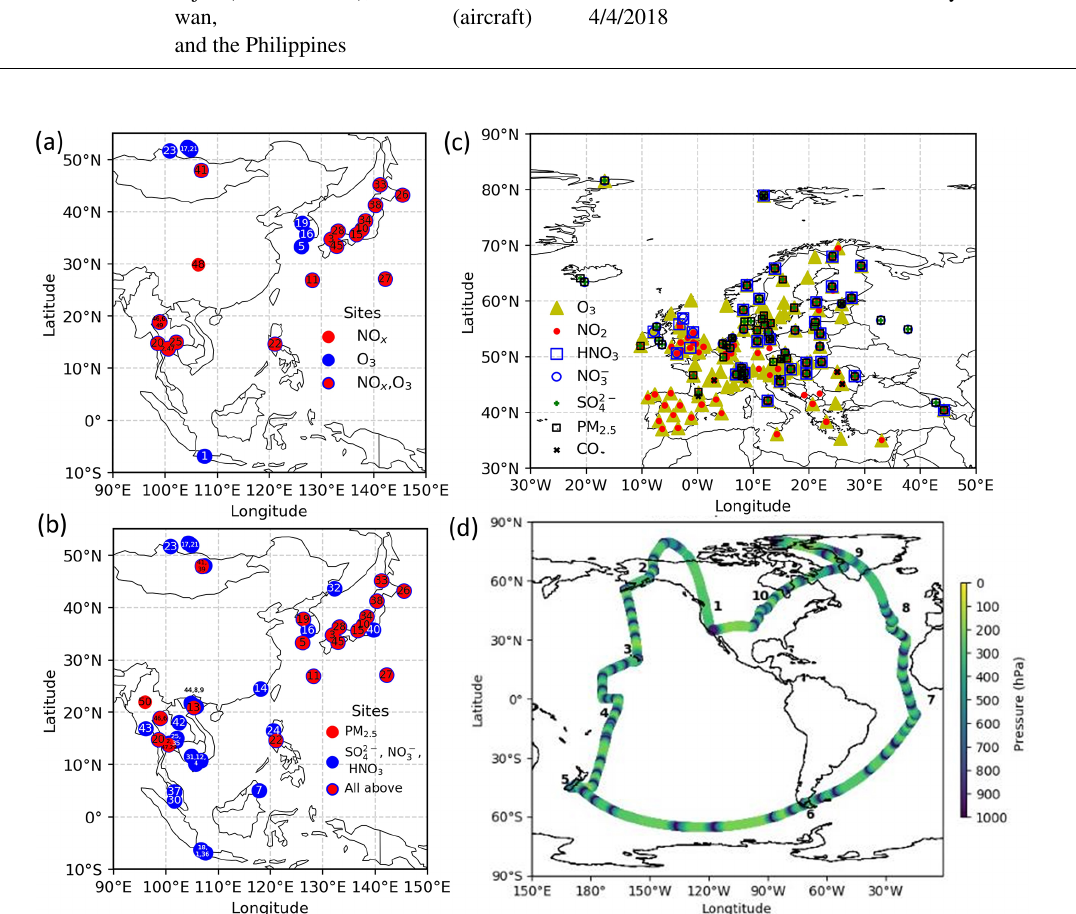
Figure 1. Location of measurements. (a) EANET stations for NO x and O 3 and (b) for PM 2 . 5 , SO 2 and (d) ATom-1 cruising altitudes are plotted. In panels (a) and (b) , each number describes the station name (see Table S1 in the Supplement). In panel (d) , the numbers show the flight